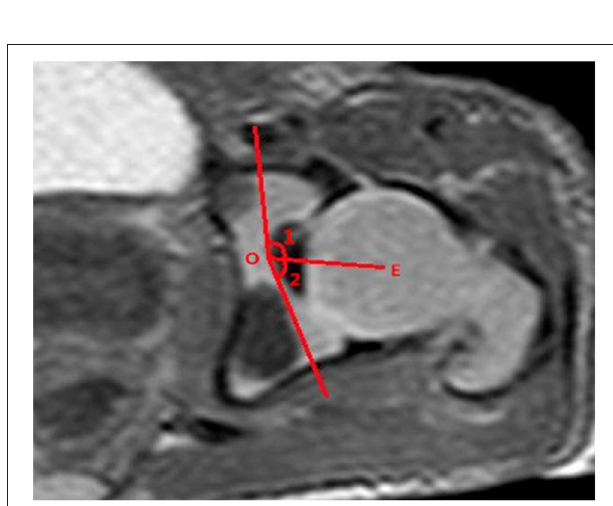
SAS 9.4 PROC MULTTEST (SAS Institute Inc., USA).